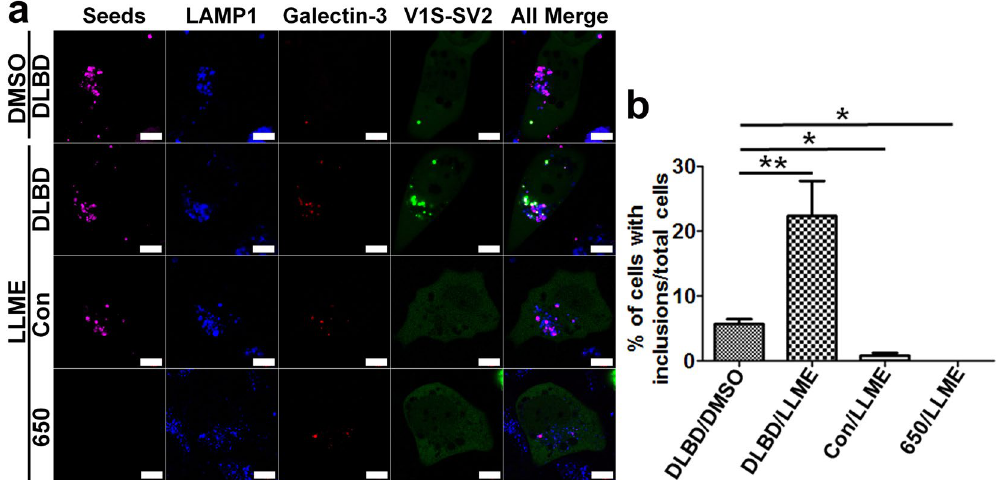
Figure 10. The loss of endo-lysosome membrane integrity renders cells more susceptible to α S aggregates seeding. (a) H4/V1S-SV2/LAMP1-eCFP/mCherry-Galectin-3 cells were treated with DyLight ® 650 (or labeled α S immunoprecipitates from lysates of DLBD3 (DLBD) and an age-matched control (Con)) for 2 days, then exposed to L-Leucyl-L-Leucine methyl ester (LLME) for 3 hours followed by imaging under confocal fluorescence microscopy. A counterpart of the DLBD sample was treated with only the vehicle (DMSO) as a non-LLME control. (b) A bar graph shows the comparison of the ratio of cells with inclusions to total cells among all groups. ( Table 2 ) Quantification of the ratio of the seeds associated with different structures in different groups in (a)